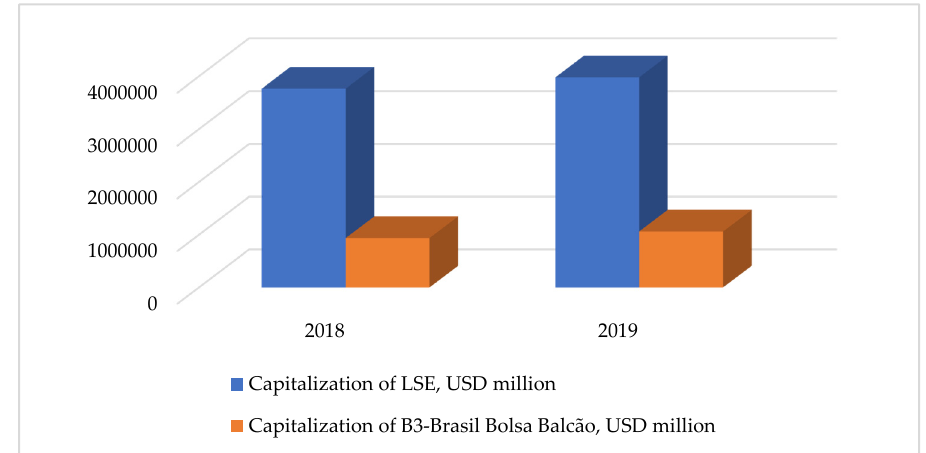
Figure 4. Comparison of the capitalization volumes of the main stock markets of the UK and Brazil for 2018–2019. Formed by the authors on the basis of The World Federation of Exchanges (2018), The World Federation of Exchanges (2019).